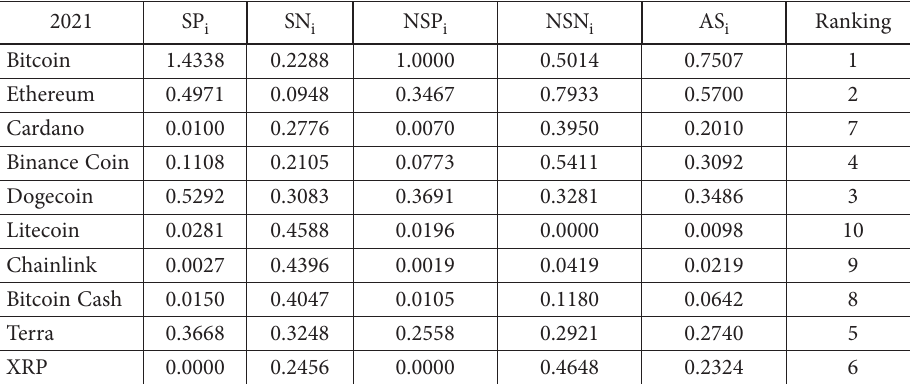
Table 5. Cryptocurrencies ranking (source: compiled by the